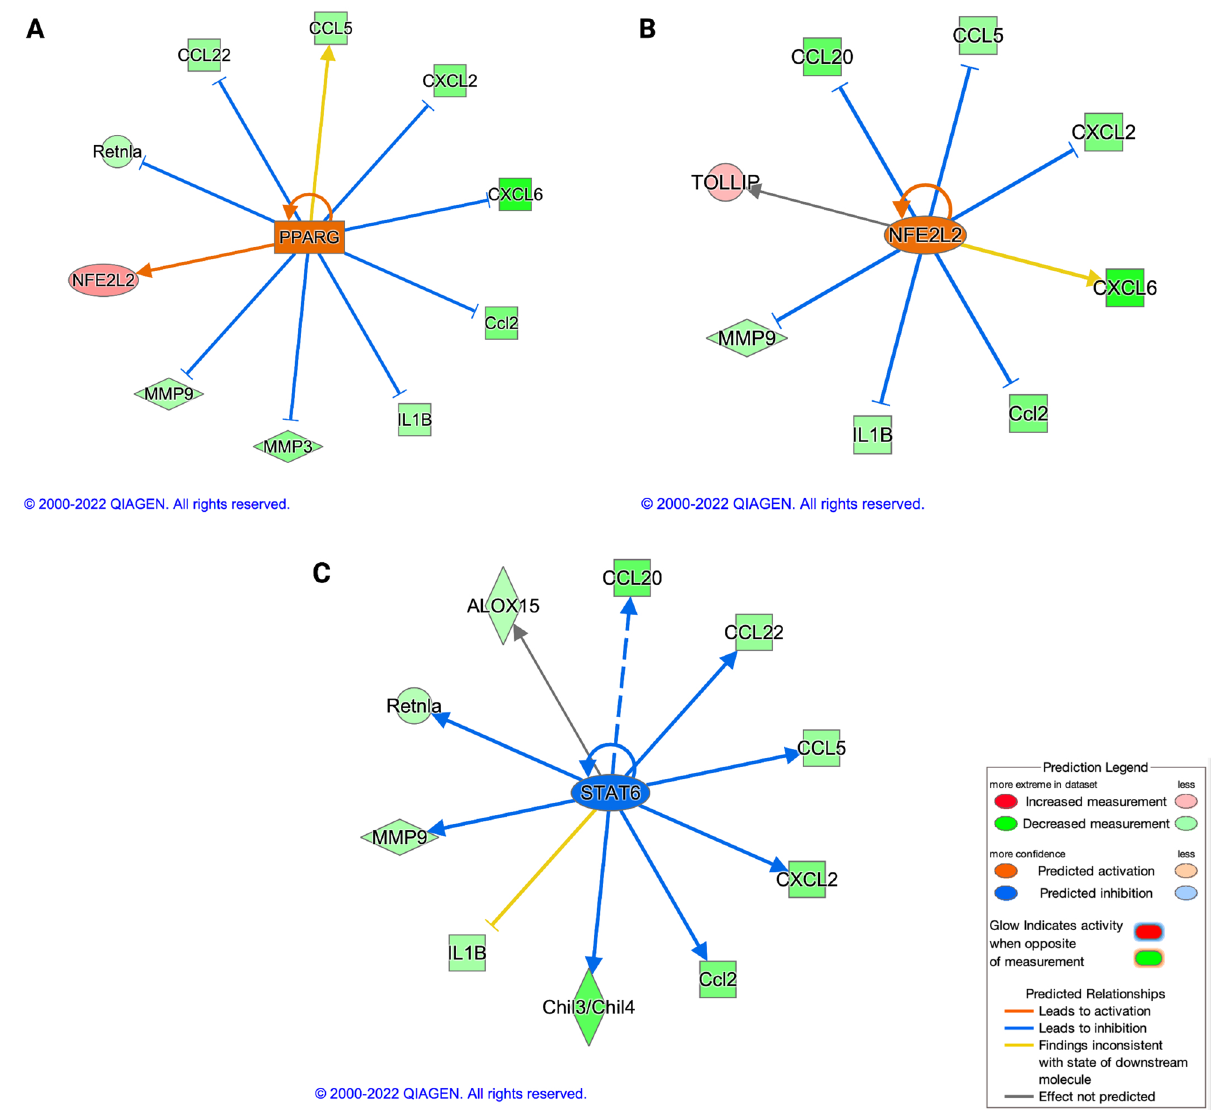
Figure 4. Significant upstream regulators identified by Qiagen’s Ingenuity Pathway Analysis (IPA). Peroxisome proliferator-activated receptor gamma (PPARγ) ( A ) and Nuclear factor, Erythroid 2 like 2 (NFE2L2) ( B ) were predicted to be significantly activated regulators whereas Signal transducer and activator of transcription 6 (STAT6) ( C ) was predicted to be significantly inhibited by IPA. Genes from the NanoString dataset in the HD group which are regulated by these individual upstream regulators are depicted in each of these panels. The level of significance was set as p-value of overlap < 0.05, with z-score < − 2 or z-score >